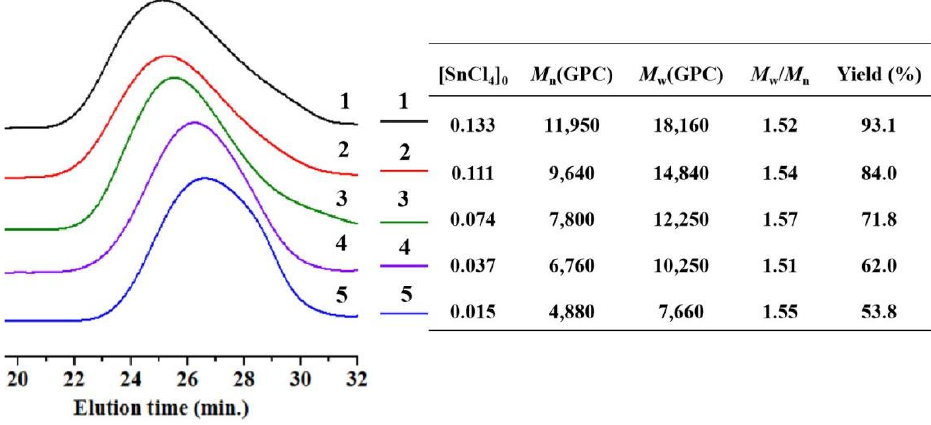
Figure 6. Effect of [SnCl 4 ] on the polymerization of p ‐ MeSt.